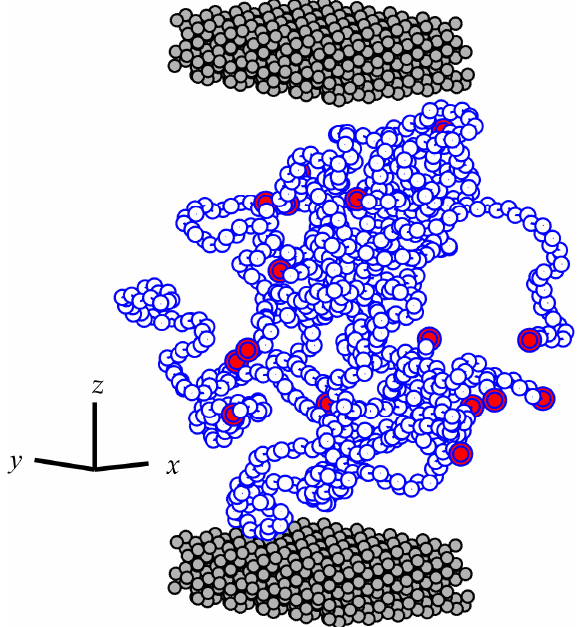
Figure 2. Schematic representation of the simulated confined systems. In the figure, only the backbone carbon atoms of the chains are shown to preserve clarity. The two ending carbon atoms of each PP chain are plotted in slightly larger circles filled with red color. The substrates are shown in black circles filled with gray color at the bottom and top of the simulation box.